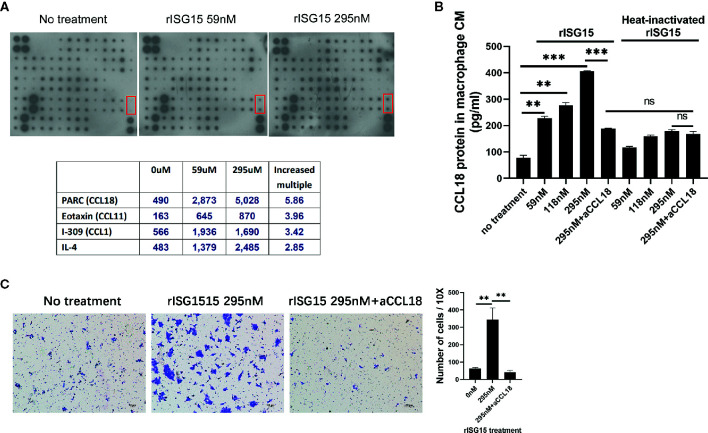
Interferon-stimulated gene 15 (ISG15)-treated macrophages promoted nasopharyngeal carcinoma (NPC) cell migration through CCL18 secretion. (A) Cytokine array of the CM of macrophages induced with rISG15 at the indicated doses for 24 h. The lower table summarizing the relative signal intensity of the indicated cytokines is presented. The red marker box indicates the site of CCL18. (B) Increased level of CCL18 in the supernatant of ISG15-treated macrophages was confirmed by ELISA. Macrophages were treated with the indicated dose of rISG15 for 24 h. The CCL18-inducing effect of ISG15 was blocked by pretreatment with a CCL18 neutralizing antibody, and was not observed in heat-inactivated rISG15. (C) The increased number of infiltrated NPC cells, as measured by transwell assay, in the presence of CM from ISG15-treated macrophages. The enhancement was abolished by anti-CCL18 antibody. Data are expressed as mean ± SD of three independent experiments. **p < 0.01 and ***p < 0.001.